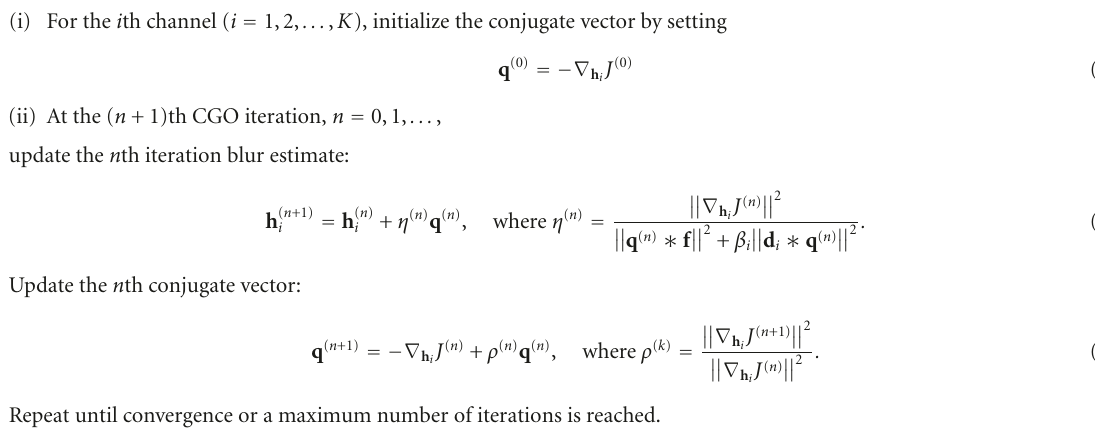
Algorithm 2: Summary of conjugate gradient optimization for blur identification.